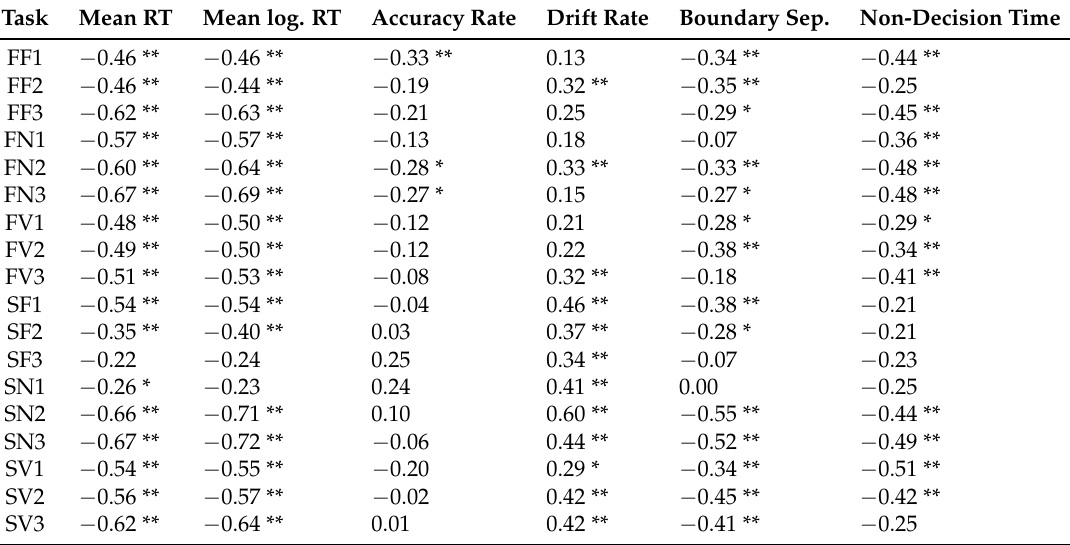
Table 4. IQ correlations of RTs, accuracy rates, and diffusion model parameters for all 18 RT tasks.